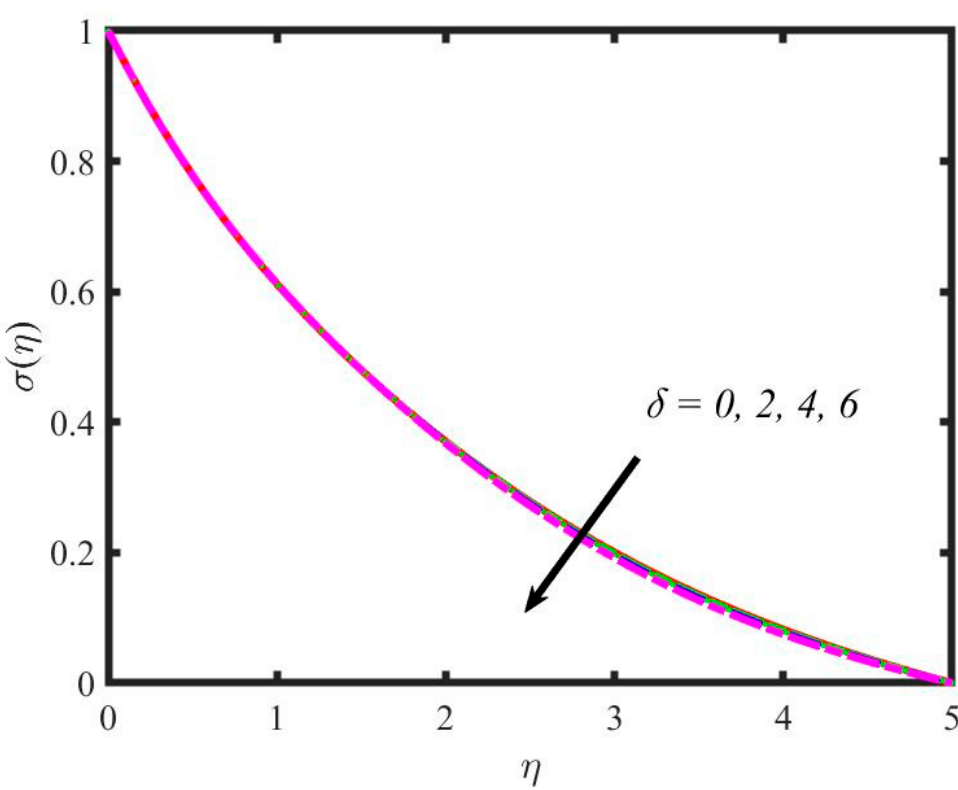
Figure 14. Variations in nanoparticle concentration for microorganisms’ parameter.